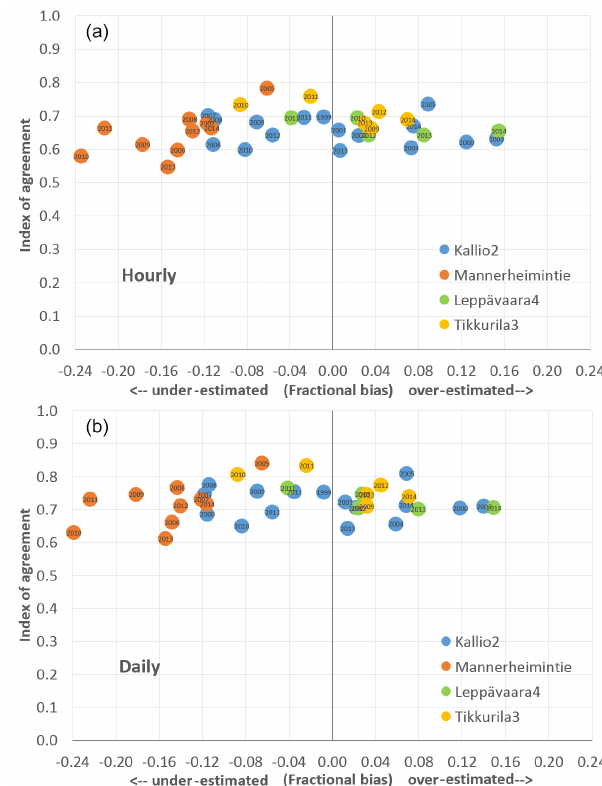
Figure 5. The annually evaluated indices of agreement and frac- tional biases, shown separately at four measurement stations and for each year, for hourly (a) and daily (b) concentrations of PM 2 . 5 . The stations have been indicated by the various colours, and the years by small text inside each dot.